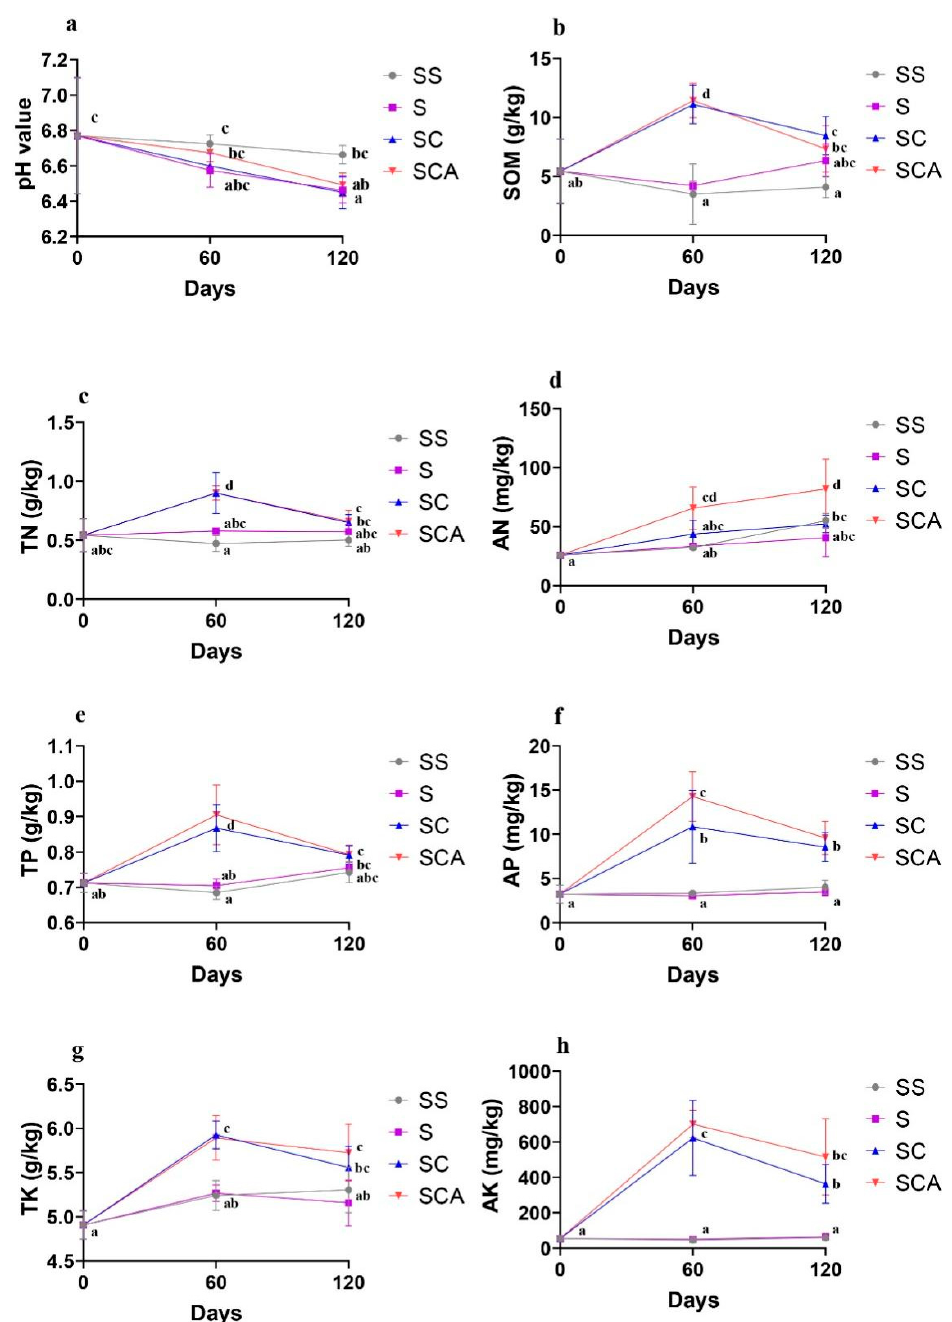
Figure 4. Chemical properties of soil samples on day 0, day 60, and day 120 during the soil amend- ment experiment. SS, sterilized soil; S, soil; SC, soil and compost; SCA, soil, compost, and Agaricus subrufescens ; ( a ), soil pH value; ( b ), soil organic matter; ( c ), soil total nitrogen; ( d ), soil alkali solution nitrogen; ( e ), soil total phosphorus; ( f ), soil available phosphorus; ( g ), soil total potassium; ( h ), soil available potassium; SOM, soil organic matter; TN, total nitrogen; AN, alkali solution nitrogen; TP, total phosphorus; AP, available phosphorus; TK, total potassium; AK, available potassium; plots with different letters across different treatments are significantly different under Dunnett’s T3 post hoc test at p < 0.05.